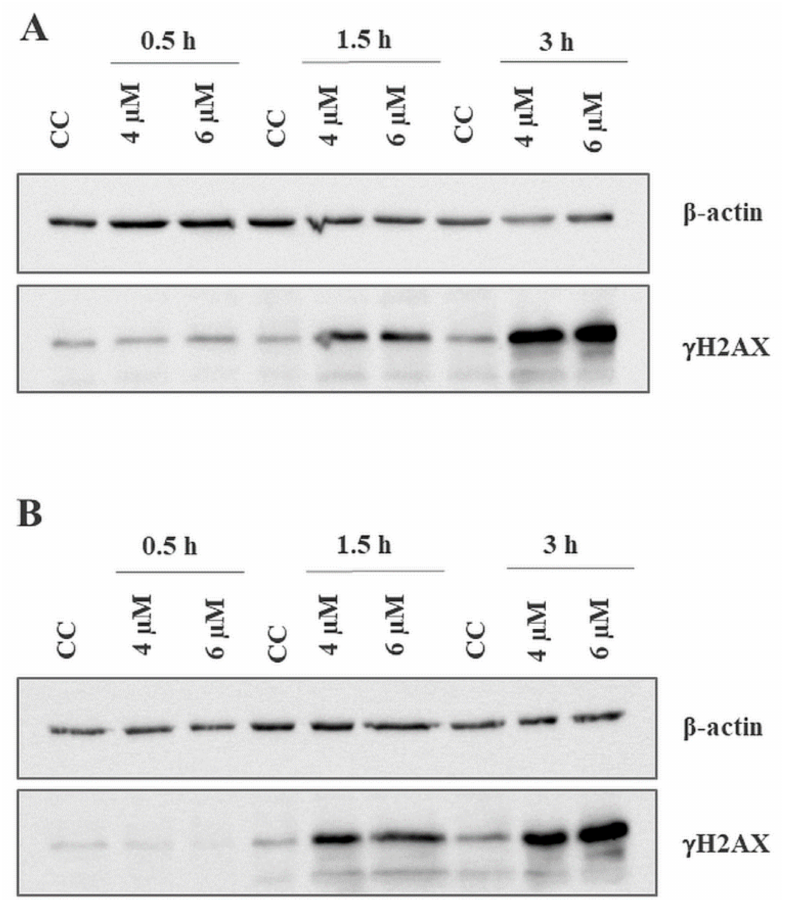
Figure 5. DNA damage generated by BITC in CLB70 and CLBL-1 cells. Increase in the amount of phosphorylated H2AX was examined in CLB70 ( A ) and CLBL-1 ( B ) cells treated with BITC for 0.5, 1.5 or 3 h by western blot